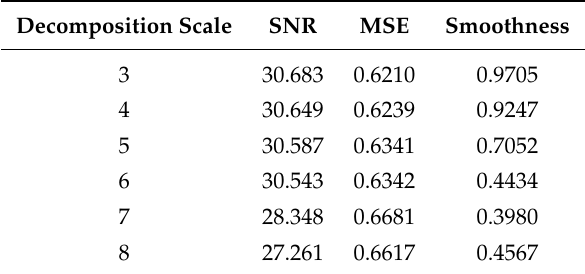
Table 1. Indexes of wavelet denoising at different decomposition scales.